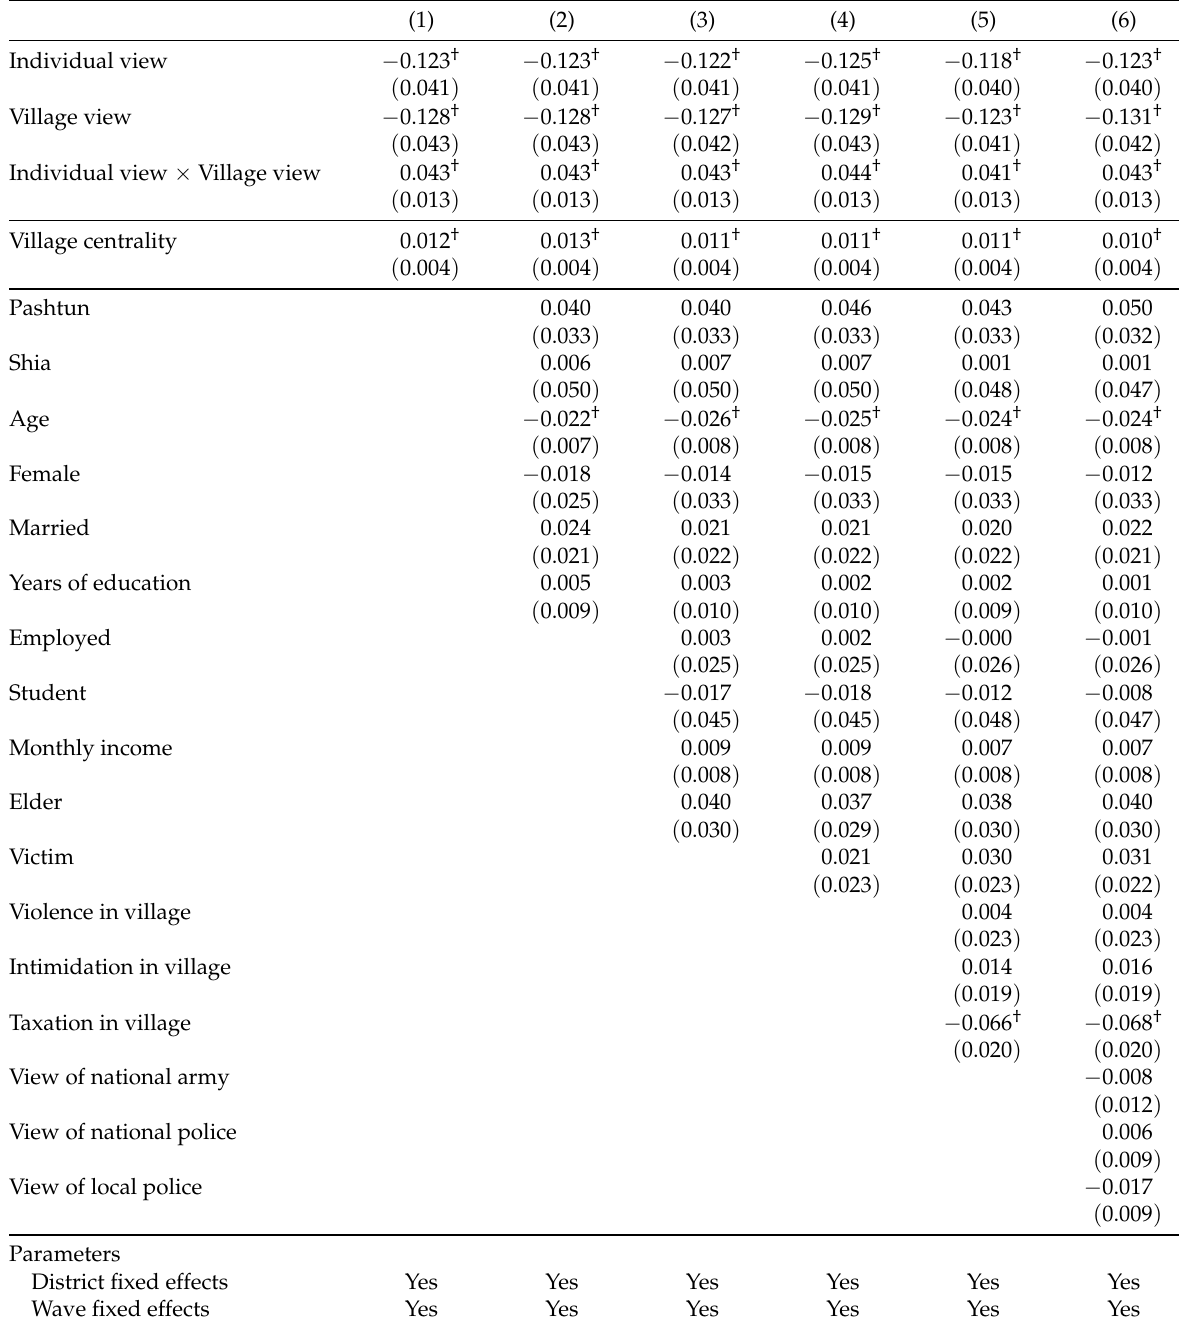
Table 7: Association between individual and village views of the Taliban and whether individual reports wrongdoing, accounting for village